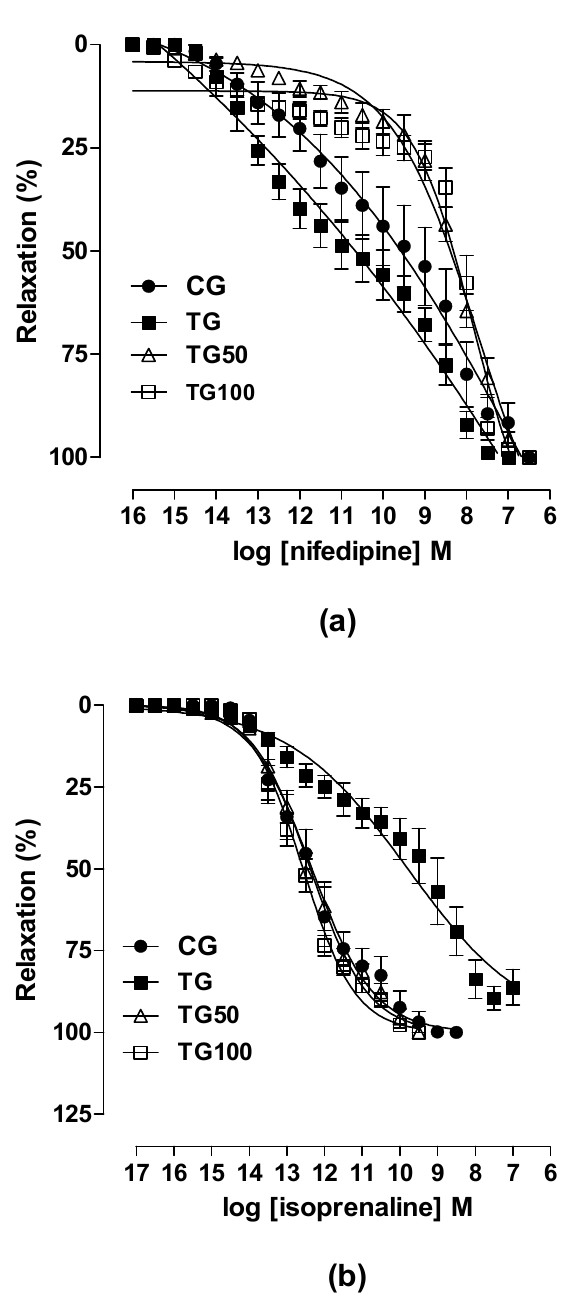
Figure 2. Effect of strength training and food supplementation with S. platensis on the cumulative concentration–response curves to nifedipine ( a ) and isoprenaline ( b ) in uterus of rats pre-contracted with KCl and oxytocin, respectively, in in CG ( ● ), TG ( ), TG50 ( Δ ) and TG100 ( ).The symbols and vertical bars represent the mean and the e.p.m., respectively ( n = 5).ANOVA one-way followed by Tukey’s post-test.